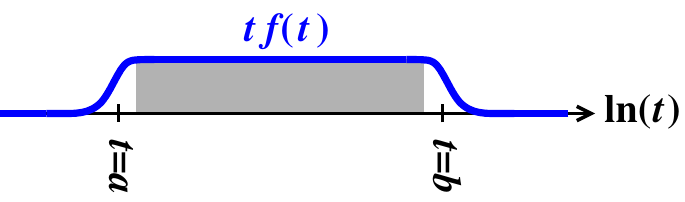
Figure 3 . A simple calculus example of an integrand f ( t ) that gives rise to a leading logarithm ln( b/a ) from the shaded region, plus a sub-leading additive constant c determined by the details of the behavior at the boundaries of that region. Note that this qualitative plot is of t f ( t ) vs. ln t , and so the logarithmic region corresponds to a flat plateau.